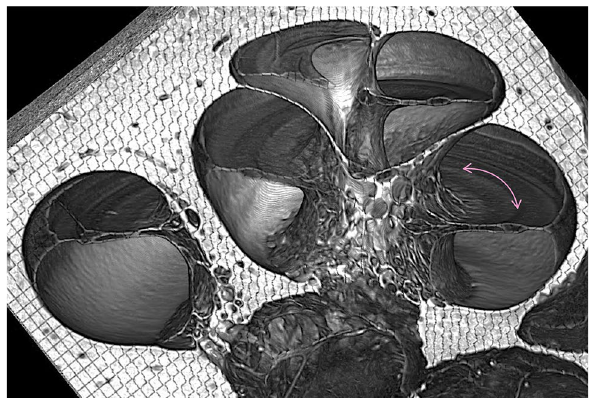
Figure 1. Virtual mid-modiolar cross-section through a human cochlea imaged using synchrotron radiation phase contrast imaging (SR-PCI). The location and orientation of the organ of Corti are indicated with the magenta arrow.